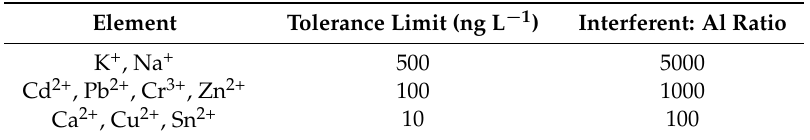
Table 2. Tolerance limits of foreign ions in the determination of 0.1 ng L − 1 Al 3+ . All measurements were made in triplicate and the results